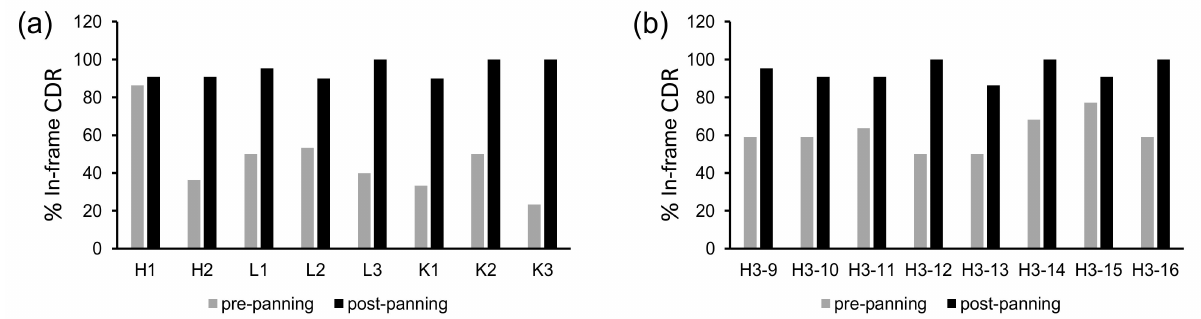
Figure 5. Percent proportions of in-frame CDRs before and after single-round panning against protein A of single-CDR scFv libraries, determined by dot blot assay. ( a ) Non-H3 CDRs, ( b ) CDR-H3s of different lengths from 9 to 16 aa (Kabat